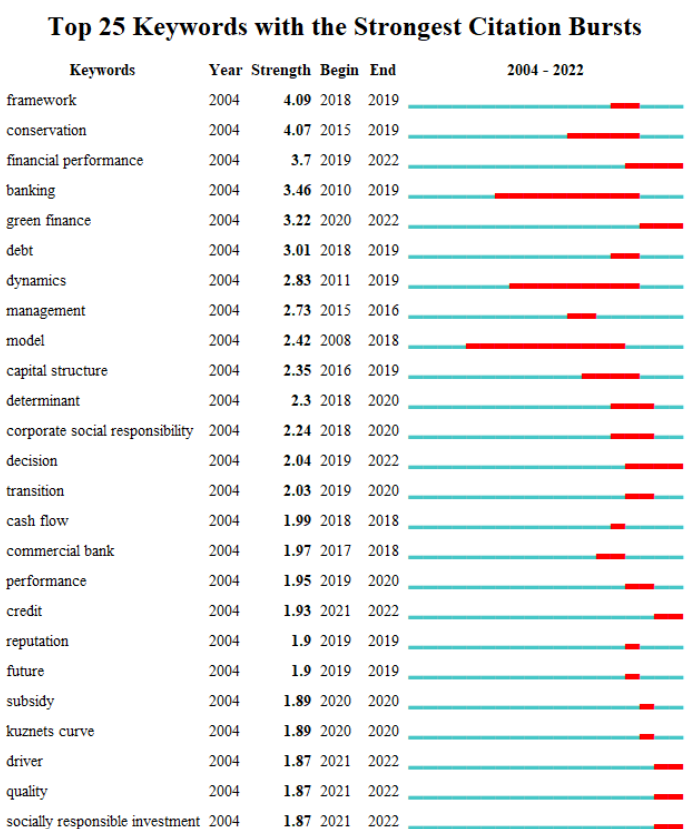
Figure 16. CNKI outburst chart.